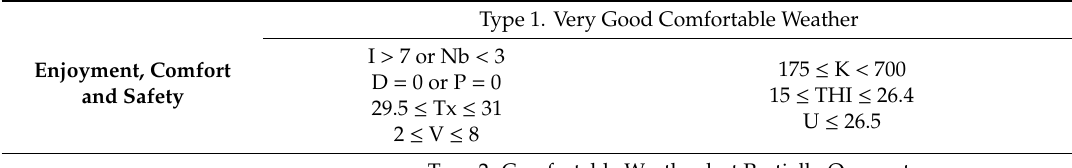
Table 4. Classification of tropical weather types for sun and beach